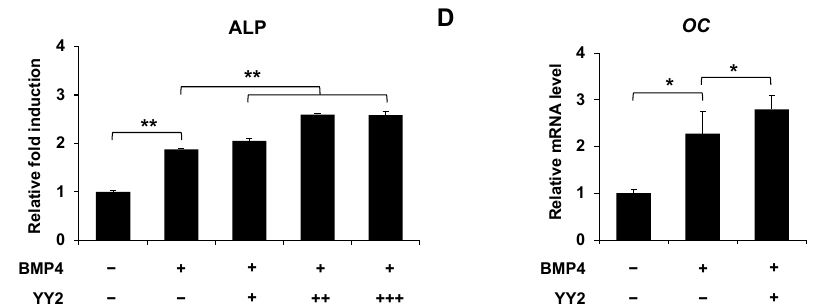
Figure 1. YY2 promotes BMP4-induced osteoblast differentiation. ( A , B ) Overexpression of YY2 significantly enhanced BMP4-induced expression of ALP in a dose-dependent manner. ALP staining and quantitative analysis of ALP activity after empty vector or increasing amounts of YY2 transfected C2C12 cells treated with or without BMP4 for 72 h. ( C , D ) Overexpression of YY2 increased the mRNA levels of osteogenic marker genes such as ALP and OC.YY2 or empty vector-transfected C2C12 cells were stimulated with BMP4 for 48 h. The expression of ALP, OC is compared by RT-qPCR. Data are expressed as mean ± SEM of at least three experiments. * p < 0.05, ** p < 0.01.